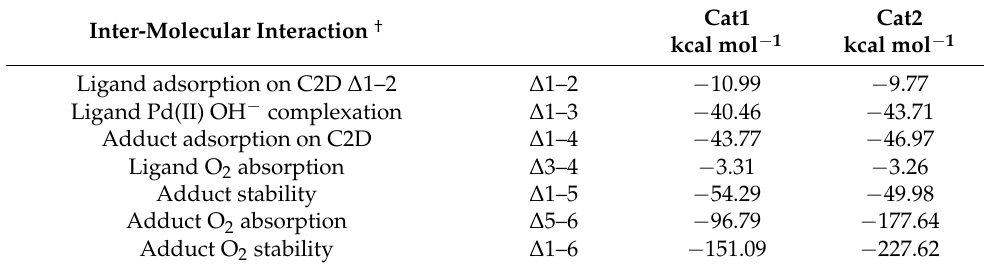
Figure 4. Potential energy surface (PES) for the elementary reactions yielding the composite catalyst: 1 to 5 (Cat2). Energy difference 6 corresponds to the catalyst/oxygen interaction, in the case of the HL2 supramolecular catalyst, UHF PM6 level of theory (compare Table 1 and Results and Discus- sion section for the details). SCF energy of (1) 𝐸𝑛𝑒𝑟𝑔𝑦 (cid:3004)(cid:2870)(cid:3005) + 𝐸𝑛𝑒𝑟𝑔𝑦 (cid:3009)(cid:3013)(cid:2870) + 𝐸𝑛𝑒𝑟𝑔𝑦 (cid:3017)(cid:3031)((cid:3010)(cid:3010)) + 𝐸𝑛𝑒𝑟𝑔𝑦 (cid:3016)(cid:3009) (cid:3127) + 𝐸𝑛𝑒𝑟𝑔𝑦 (cid:3016) , (2) 𝐸𝑛𝑒𝑟𝑔𝑦 (cid:3004)(cid:2870)(cid:3005)(cid:2879)(cid:3009)(cid:3013)(cid:2870) + 𝐸𝑛𝑒𝑟𝑔𝑦 (cid:3017)(cid:3031)((cid:3010)(cid:3010)) + 𝐸𝑛𝑒𝑟𝑔𝑦 (cid:3016)(cid:3009) (cid:3127) + 𝐸𝑛𝑒𝑟𝑔𝑦 (cid:3016) , (3) (cid:3118) (cid:3118) 𝐸𝑛𝑒𝑟𝑔𝑦 (cid:3004)(cid:2870)(cid:3005) + 𝐸𝑛𝑒𝑟𝑔𝑦 (cid:3009)(cid:3013)(cid:2870)(cid:2879)(cid:3017)(cid:3031)((cid:3010)(cid:3010))(cid:2879)(cid:3016)(cid:3009) (cid:3127) + 𝐸𝑛𝑒𝑟𝑔𝑦 (cid:3016) , (4) 𝐸𝑛𝑒𝑟𝑔𝑦 (cid:3004)(cid:2870)(cid:3005) + 𝐸𝑛𝑒𝑟𝑔𝑦 (cid:3009)(cid:3013)(cid:2870)(cid:2879)(cid:3017)(cid:3031)((cid:3010)(cid:3010))(cid:2879)(cid:3016)(cid:3009) (cid:3127) (cid:2879)(cid:3016) , (5) (cid:3118) (cid:3118) 𝐸𝑛𝑒𝑟𝑔𝑦 (cid:3004)(cid:2870)(cid:3005)(cid:2879)(cid:3009)(cid:3013)(cid:2870)(cid:2879)(cid:3017)(cid:3031)((cid:3010)(cid:3010))(cid:2879)(cid:3016)(cid:3009) (cid:3127) + 𝐸𝑛𝑒𝑟𝑔𝑦 (cid:3016) , (6) 𝐸𝑛𝑒𝑟𝑔𝑦 (cid:3004)(cid:2870)(cid:3005)(cid:2879)(cid:3009)(cid:3013)(cid:2870)(cid:2879)(cid:3017)(cid:3031)((cid:3010)(cid:3010))(cid:2879)(cid:3016)(cid:3009) (cid:3127) (cid:2879)(cid:3016) . The energy level (1) represents the sum of the energies of the non-interacting species, while (6) represents the energy of the complete catalyst supermolecule. The energy of the O 2 molecule was calculated in the electronic triplet state. The energy levels of the six steps have been normalized to the energy of state (1), which corresponds to a 744.78 kcal mol − 1 absolute value. Table 1. Interaction energies of reactivity steps of Cat1 and Cat2 supramolecular catalysts.